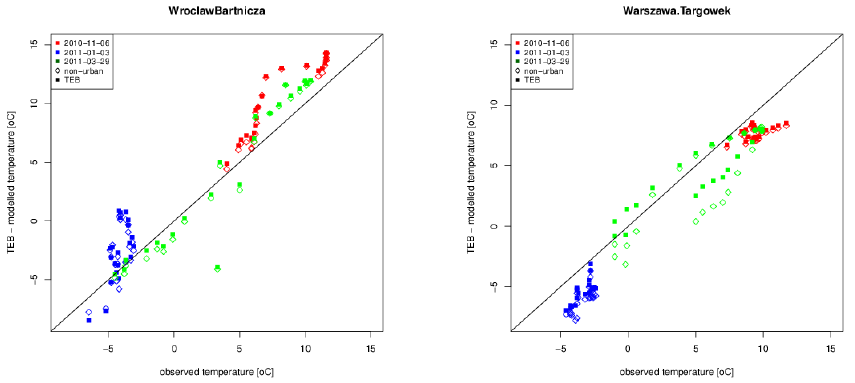
Figure 17 Near surface temperature measured at Wroclaw-Bartnicza and Warsaw-Targowek air-quality monitoring stations and calculated with the GEM-AQ model. Full colour with the TEB parameterization and the reference case outlined colour, red: 6 November 2010; blue: 3 January 2011; green: 29 March 2011.